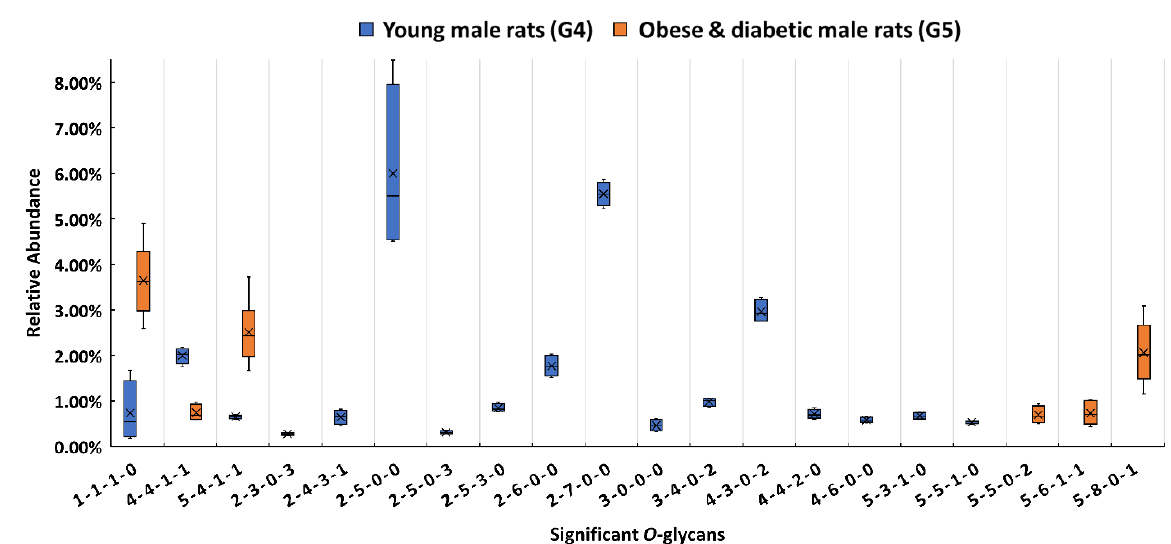
Figure 4. Box plot for relative abundance of significant O -glycans ( p < 0.001) between male control (G4) and obese and diabetic male (G5). The putative structure was assigned to each glycan composition. The X axis denotes the four-digit codes for O -glycan compositions. The Y axis is the relative abundance. Error bars are the 95% confidence interval.